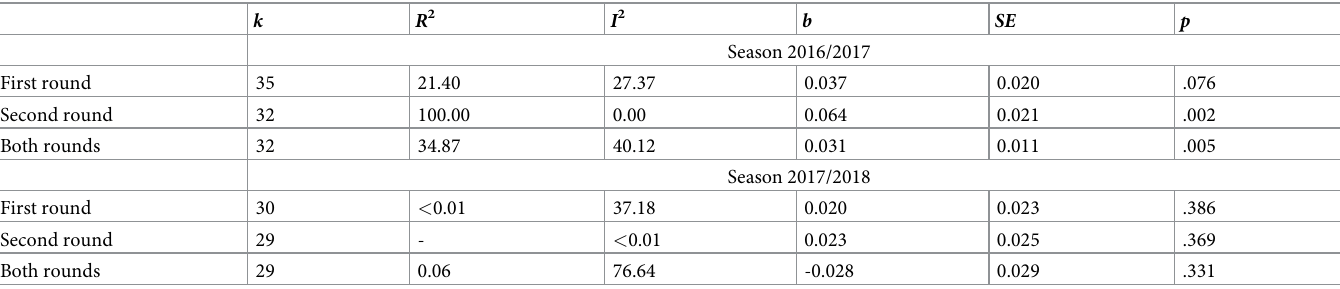
Table 3. Mixed-effects meta-regressions of absolute effect sizes for wind point associations on standard deviations of wind points within competitions.